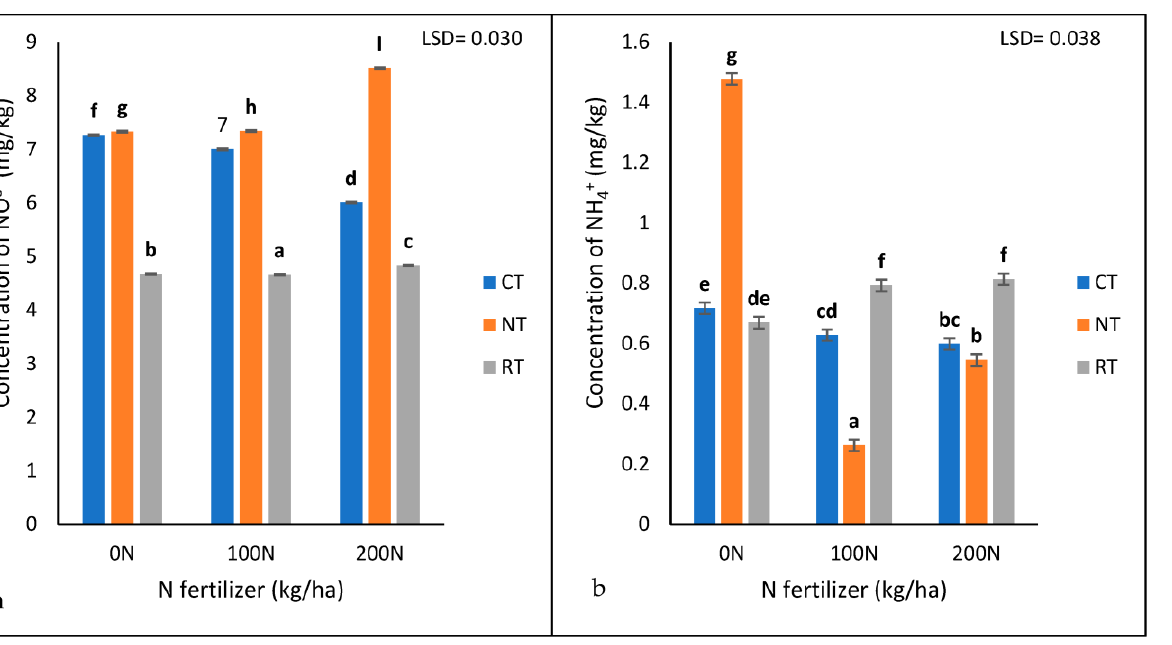
Figure 4. The concentrations of extractable NO 3 − ( a ) and NH 4+ ( b ) under three tillage treatments (NT, RT, and CT) and three nitrogen (Urea) treatments (0, 100, and 200 kg/ha) recorded after 17 years of trial establishment. N = nitrogen fertiliser. The bars not sharing the same letter differ significantly at LSD ( p = 0.05).